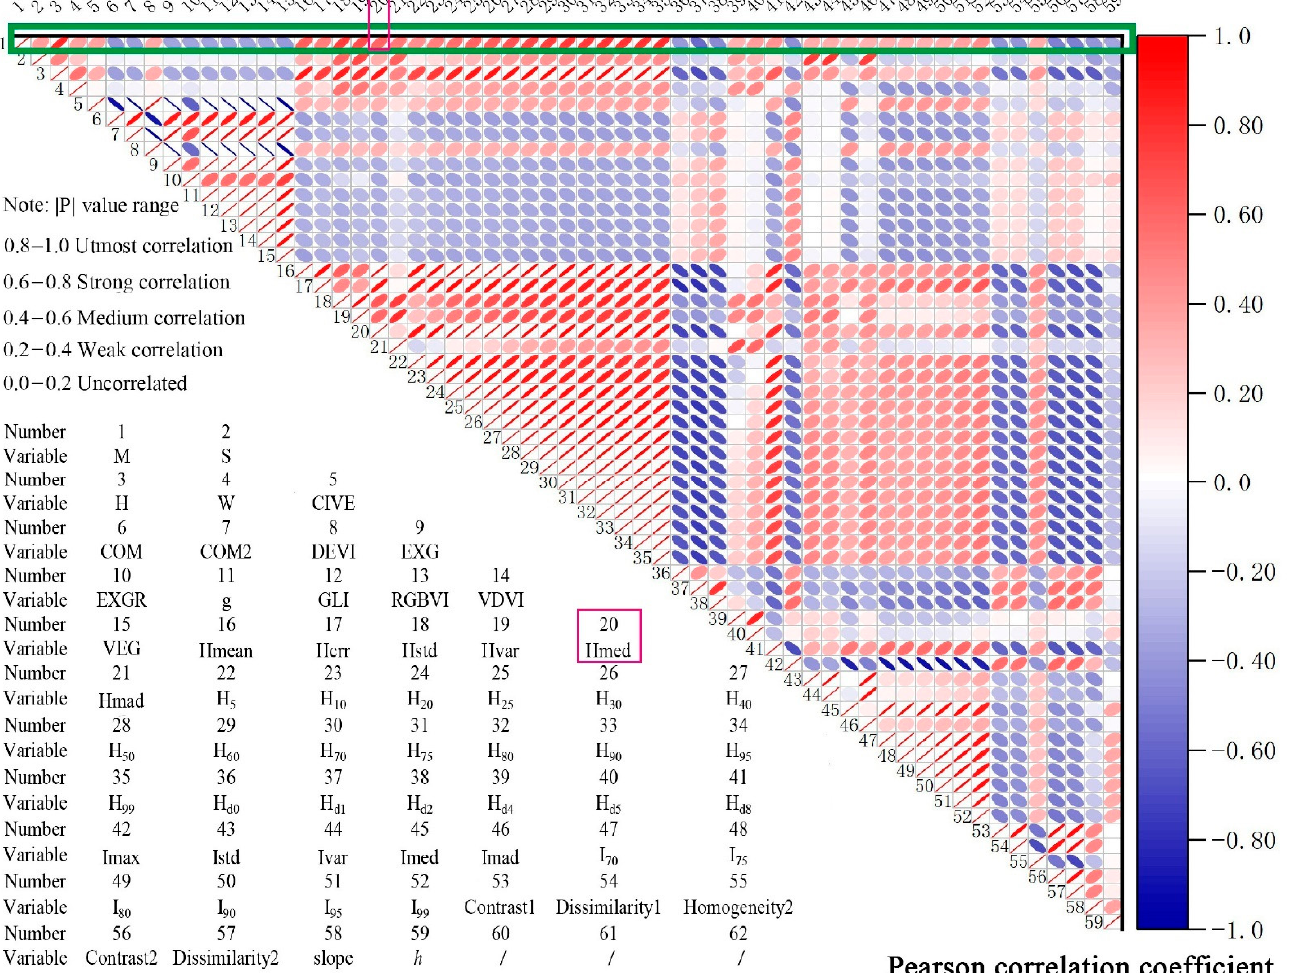
Figure 9. Plot of correlation coefficients between the dependent variable (volume M) and the independent variable. Red represents positive correlation and blue represents negative correlation, and the smaller the ellipse and the darker the color, the higher the correlation between the two variables. The green box indicates that the column is the correlation between the dependent variable and each independent variable, and each ordinal number in the figure represents a variable. For example, 20 represents H med , and its correlation with the dependent variable M(1) is the ellipse corresponding to the number 20 in the green box.